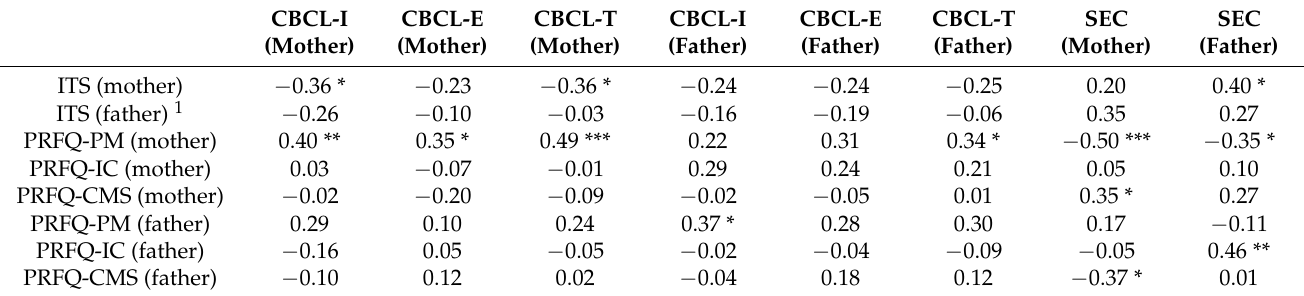
Table 3. Correlations between parental mentalizing, child’s psychological symptoms and child’s social–emotional